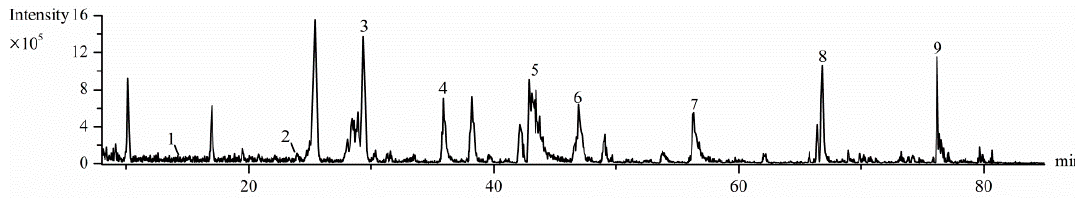
Figure 5. The LC-MS base peak chromatogram (BPC) of H. abyssinica (EA fraction) in the negative ion mode.